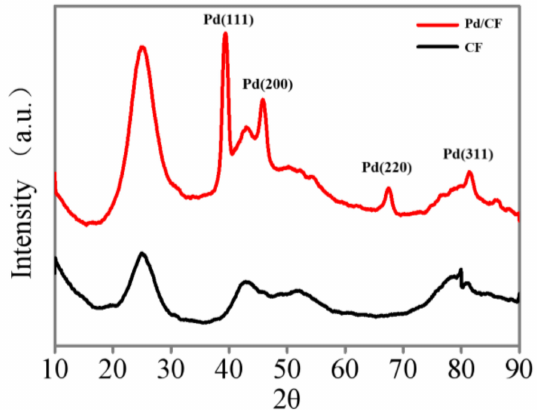
Figure 2. XRD of carbon felt electrode and Pd-loaded carbon felt electrode (0.5 mg/cm 2